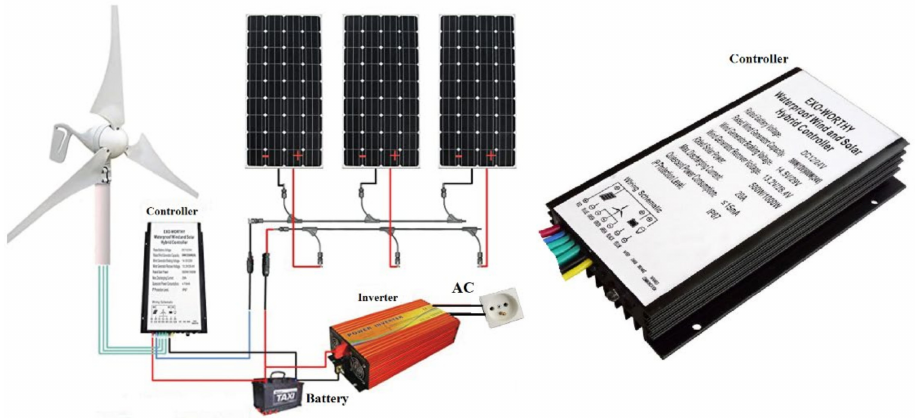
Figure 2. A kit example for mounting a hybrid generator (source, prepared by the authors).